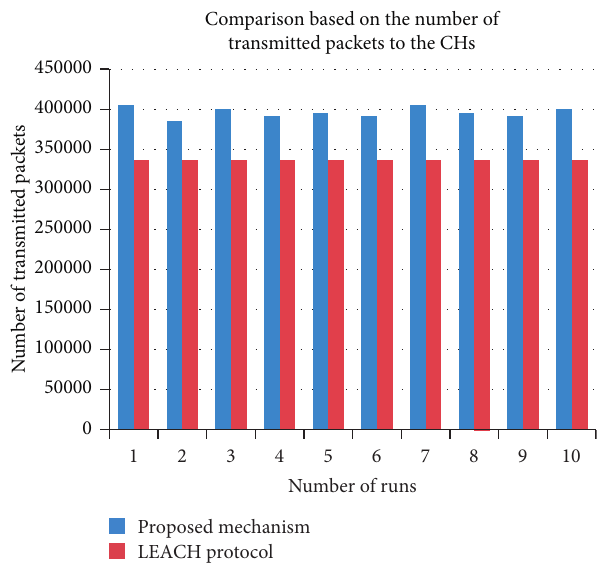
Figure 10: Comparison between the two mechanisms based on the number of the transmitted packets to the CHs.